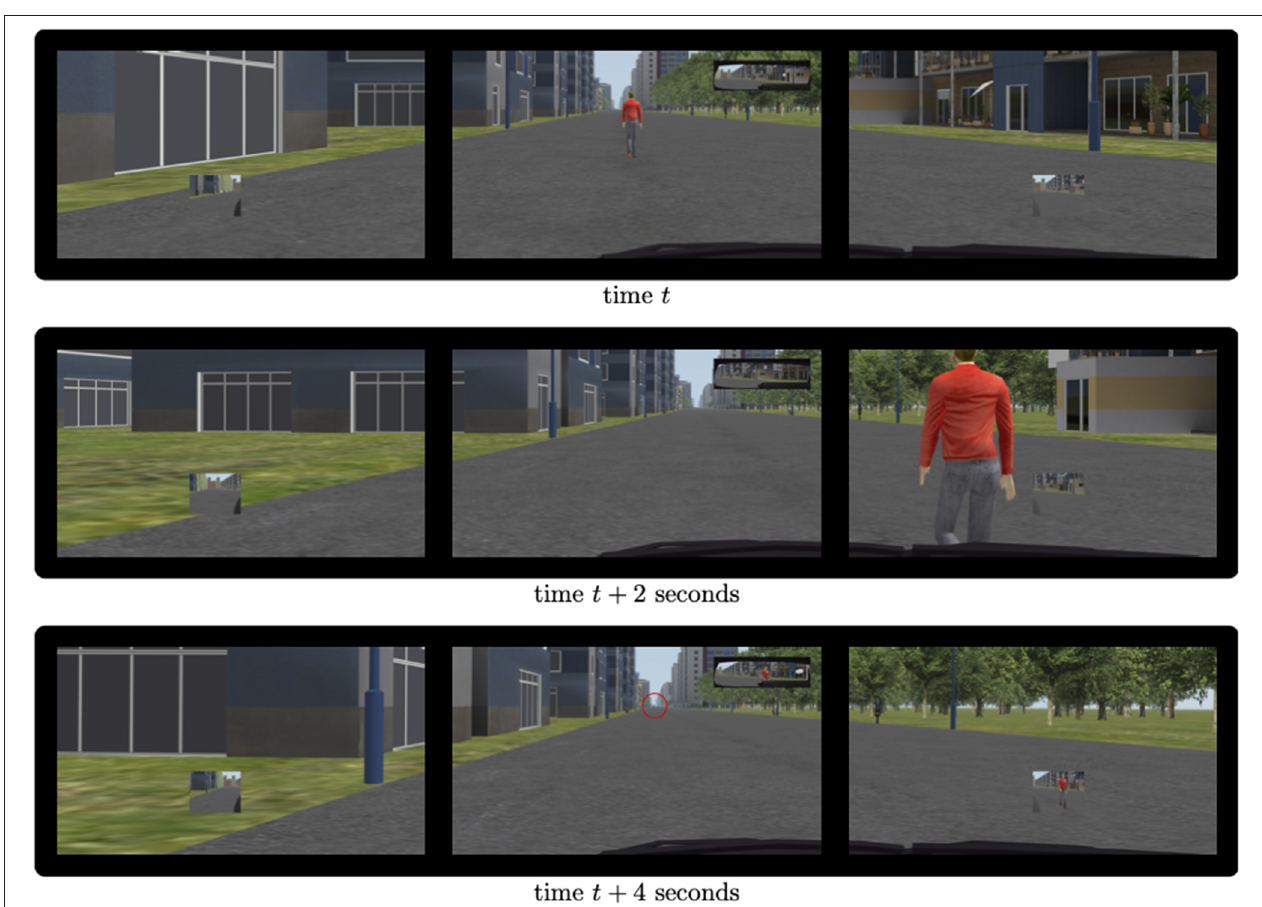
FIGURE 2 | Example of the participant’s 120 ◦ view during a left avoidance manoeuvre. (Top) The approaching phase of a pedestrian walking in the same direction as the vehicle. (Middle) The vehicle’s position 2 s later when it had started its avoidance manoeuvre. (Bottom) The end of the manoeuvre. The avoided pedestrian is visible in the left and center rear-view mirrors. The following pedestrian (circled in red) can hardly be distinguished. This is because each avoidance manoeuvre was separated by 25 s to ensure the independence of the